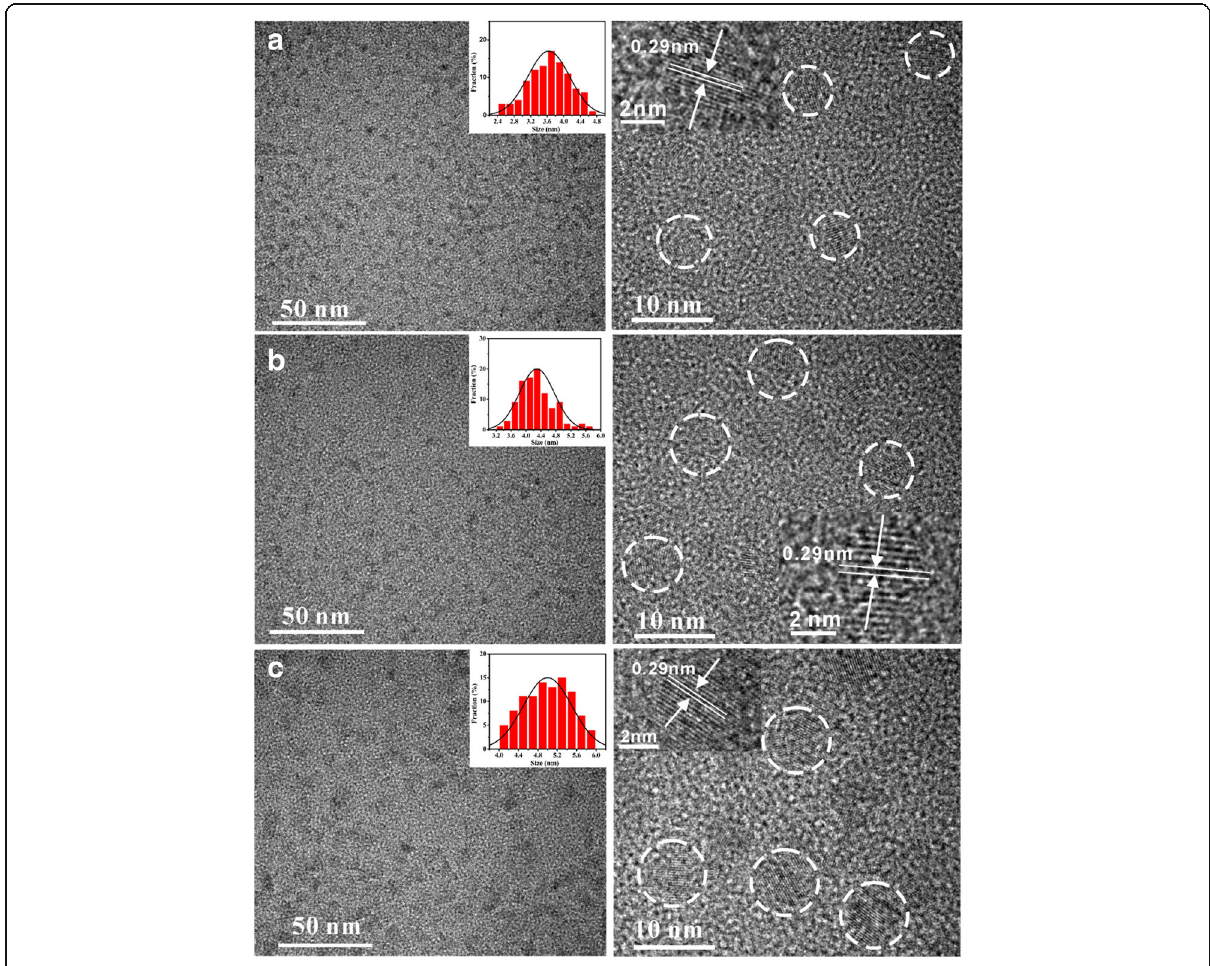
Fig. 1 TEM and HRTEM images of a InP/ZnS QDs (Mn/In = 0), b Mn:InP/ZnS QDs (Mn/In = 0.4), and c Mn:InP/ZnS QDs (Mn/In = 0.6). The inset of the HRTEM images corresponds to single QD at high magnification while the scale bar is 2